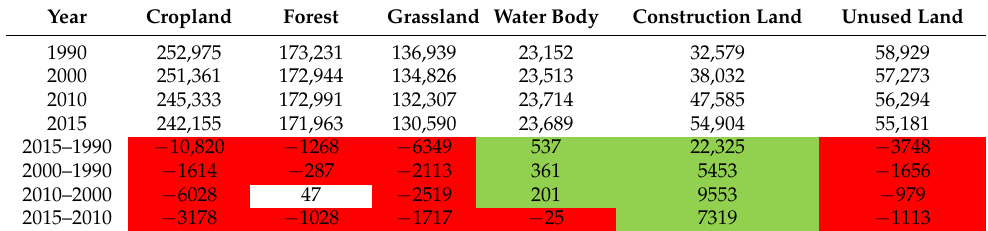
Figure 3. Spatial patterns of LULC in AEZs in 1990, 2000, 2010 and 2015. Table 2. LULC and LULCC from 1990 to 2015 (unit, Km 2 ; green color for positive change and red color for negative